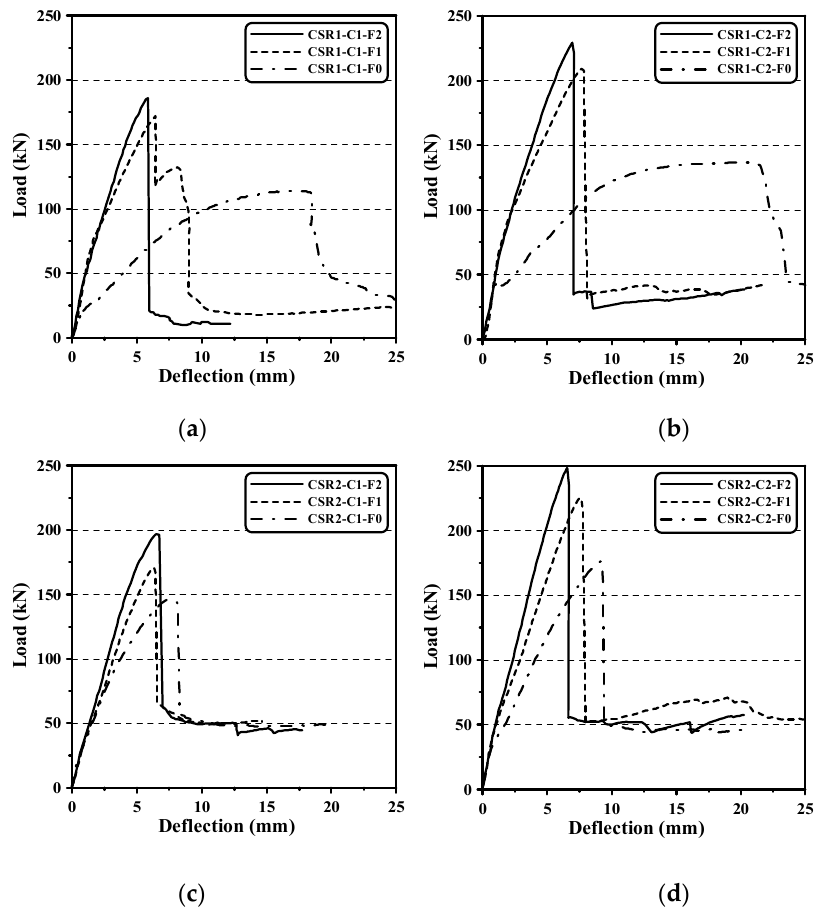
Figure 7. Load-deflection curves: ( a ) CSR1-C1 series of specimens; ( b ) CSR1-C2 series of specimens; ( c ) CSR2-C1 series of specimens; ( d ) CSR2-C2 series of